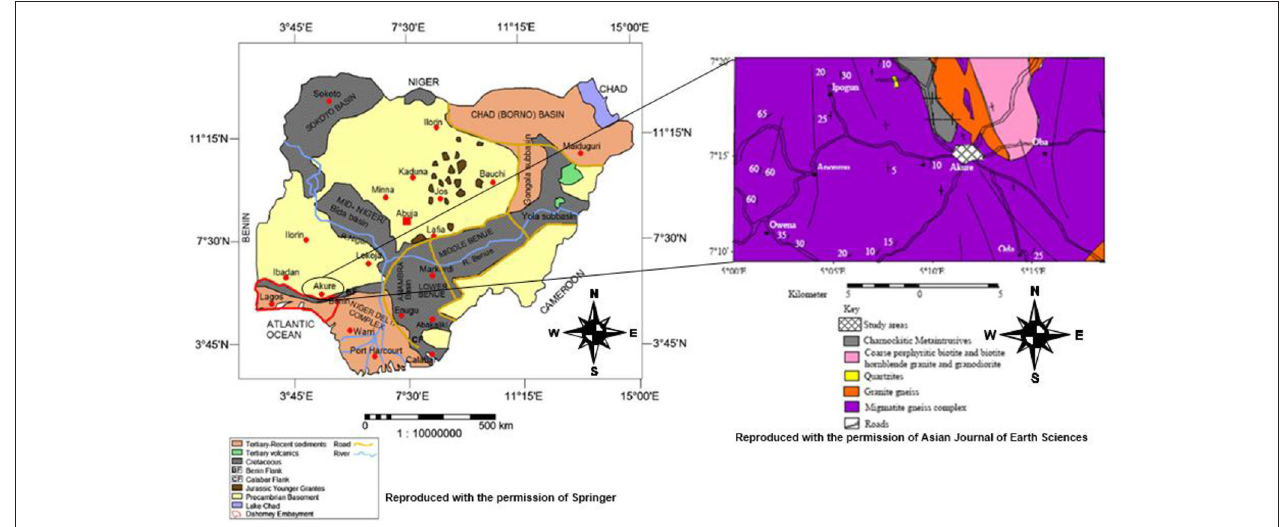
FIGURE 2 | Geological terrains in Nigeria revealing the geology of Akure and its environs. Source: Obaje (2015) and Ademeso